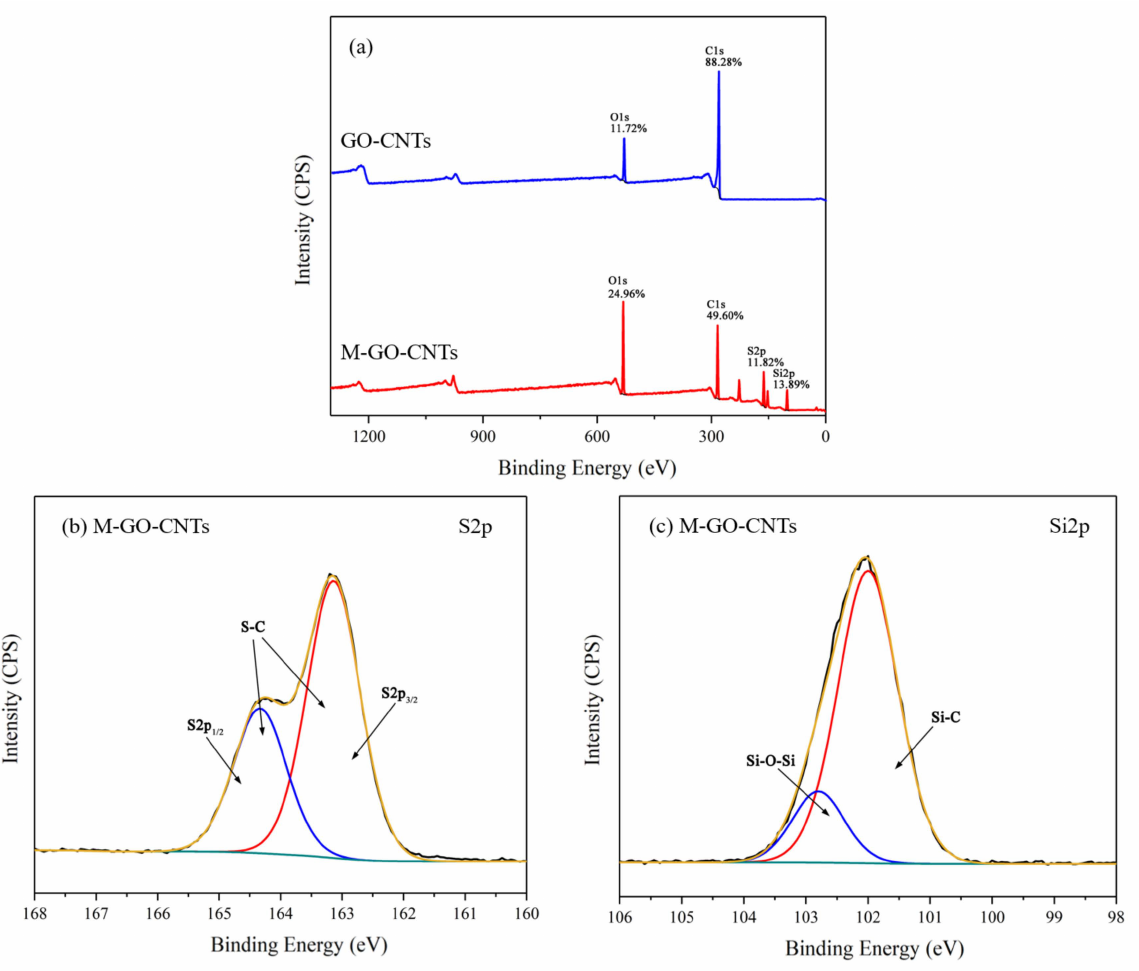
Figure 5. XPS wide-scan spectrum ( a ), S2p ( b ), and Si2p ( c ) high-resolution spectra of